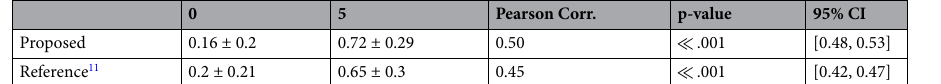
0 5 Pearson Corr. p-value 95% CI Proposed 0.16 ± 0.2 0.72 ± 0.29 0.50